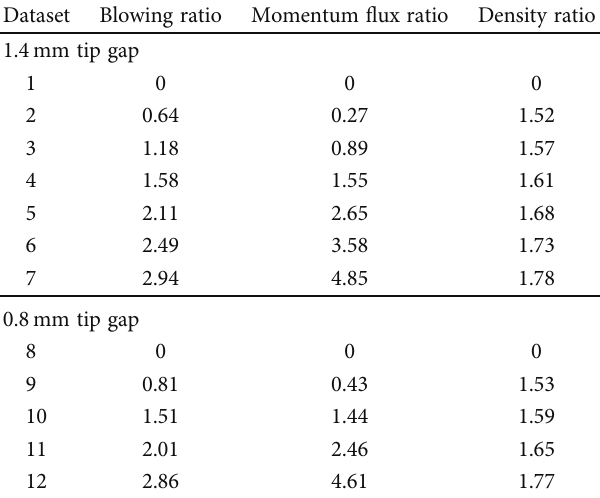
Table 1: Film cooling experimental conditions.